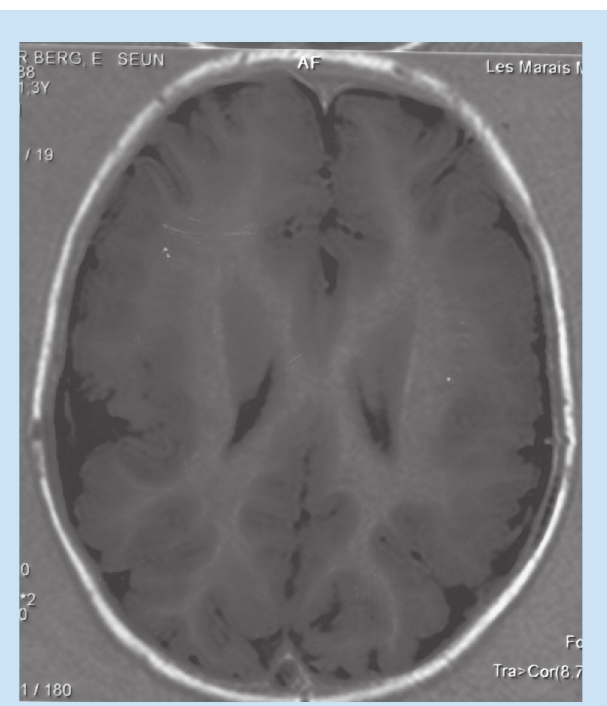
Fig. 2. Axial T1-weighted image with inversion recovery sequence. Irregular cortical surface with small and multiple gyri. Note the loss of cortex.